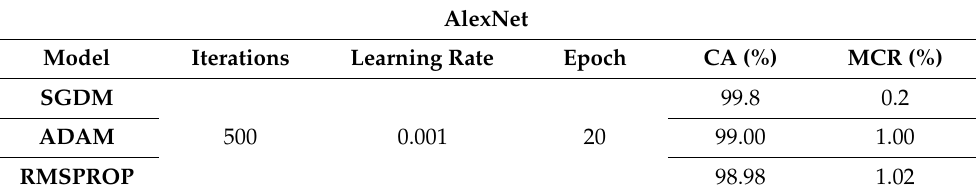
Table 3. Training results of AlexNet simulation models empowered with IoMT and